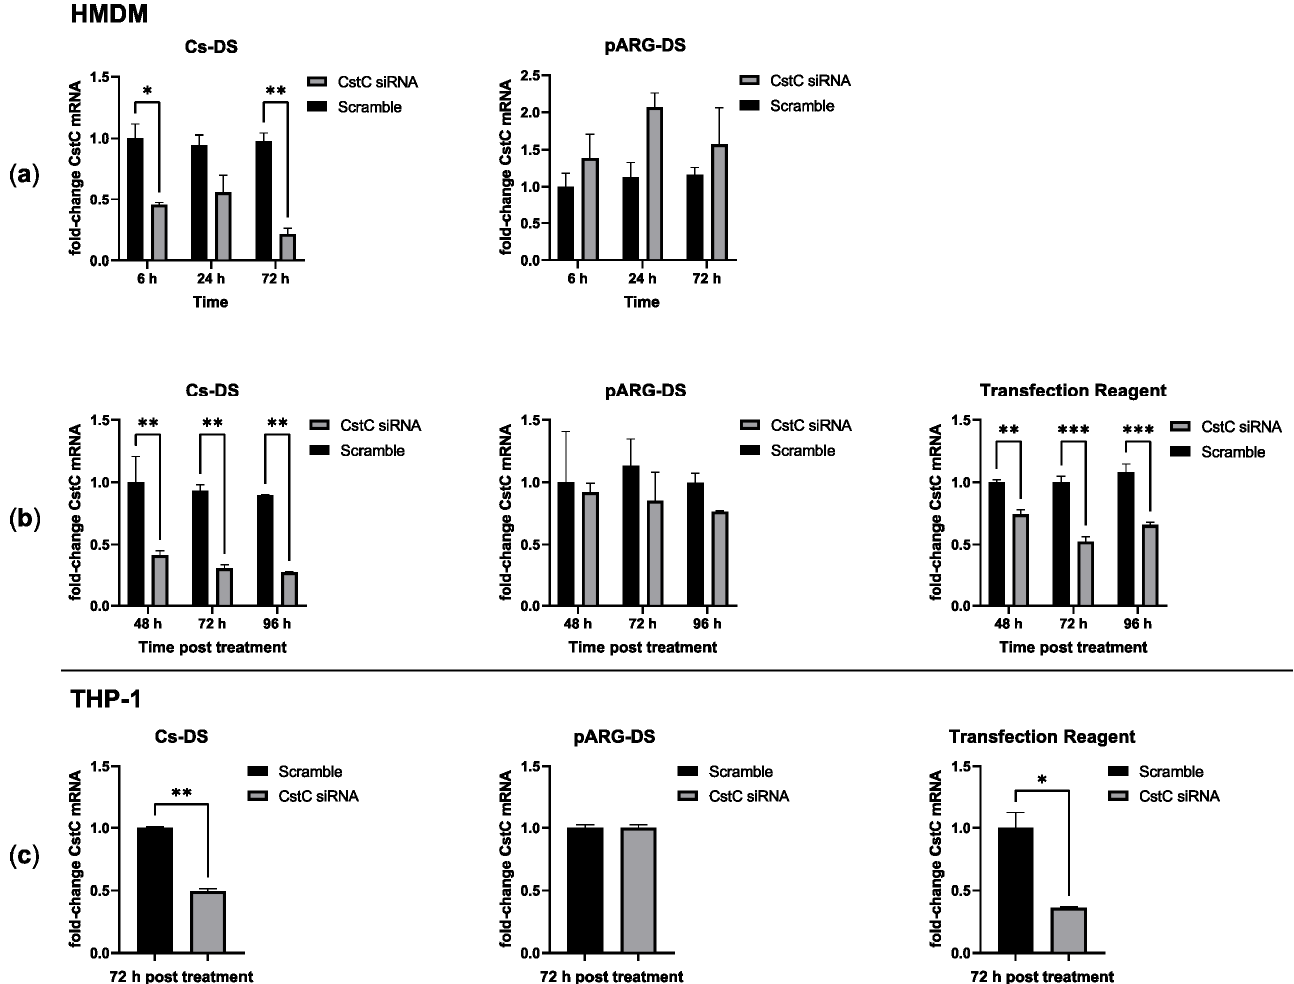
Figure 2. Cystatin C mRNA-silencing efficacy of Cs and pARG particles loaded with anti-CstC siRNA: ( a ) CstC mRNA levels were measured using qPCR in HMDMs treated with 1 mg/mL of DSs for different periods, after which the cells were washed and incubated until 72 h post-treatment; ( b ) alternatively, cells were left in contact with DSs for the selected periods; ( c ) THP-1 macrophages were also treated under the same conditions but only for 72 h. A transfection reagent (ScreenfectA) was used for comparison. Bars represent the average of three independent experiments, and the error bars depict the standard error of the mean. For each plot, the values are presented relative to the scramble control from the earliest time point. * p ≤ 0.05, ** p ≤ 0.01, and *** p ≤ 0.001.